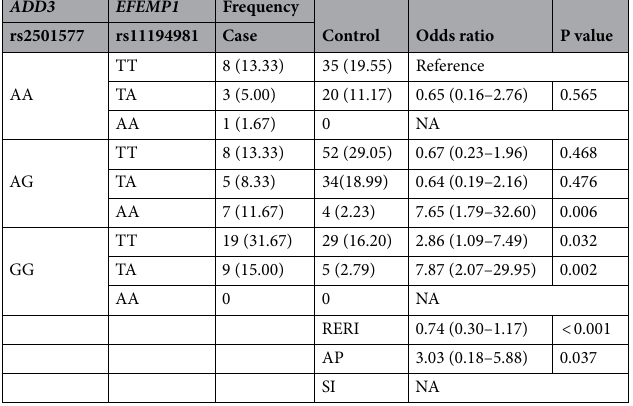
Table 4. Analysis of the biological interactions between ADD3 and EFEMP1 genotypes comparing the biliary atresia cases and controls.